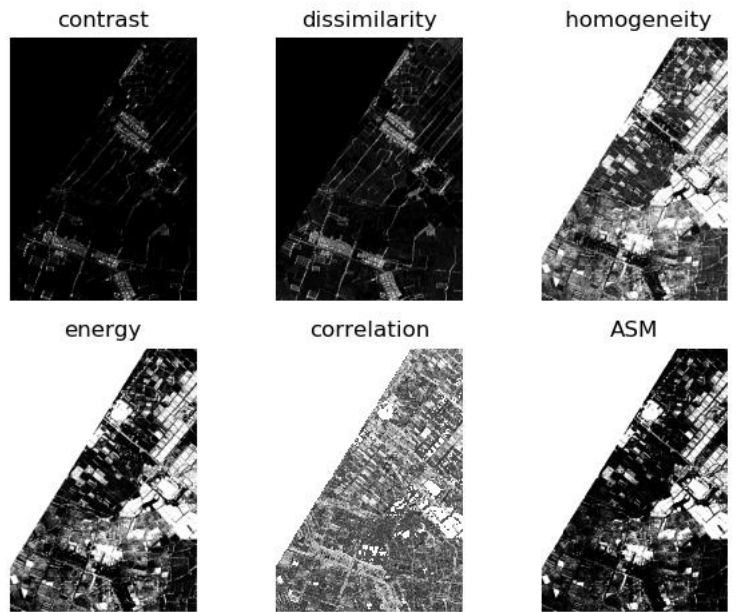
Figure 8. Second-order gray-level co-occurrence matrix (GLCM) features of hyperspectral image data.